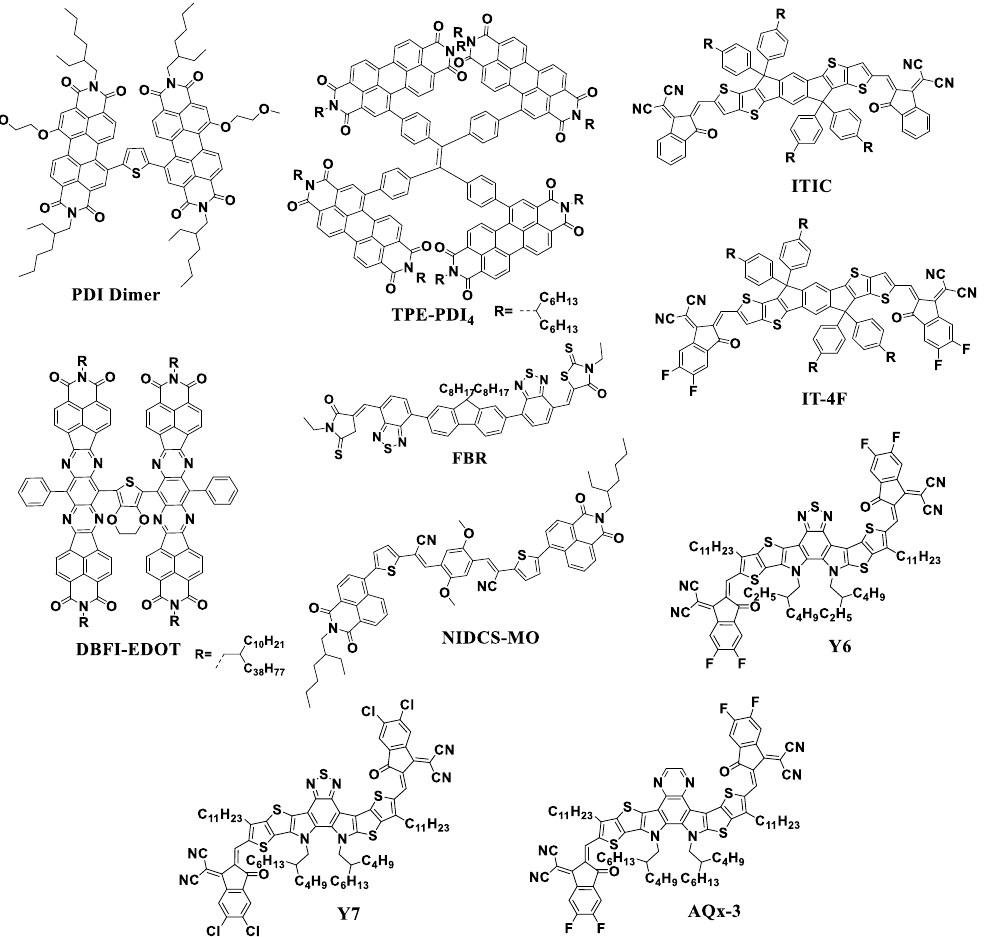
Figure 8. Molecular structures of different types of NFAs: PDI Dimer, TPE-PDI4, FBR, NIDCS-MO, ITIC, IT-4F, Y6, Y7, and AQx-3.